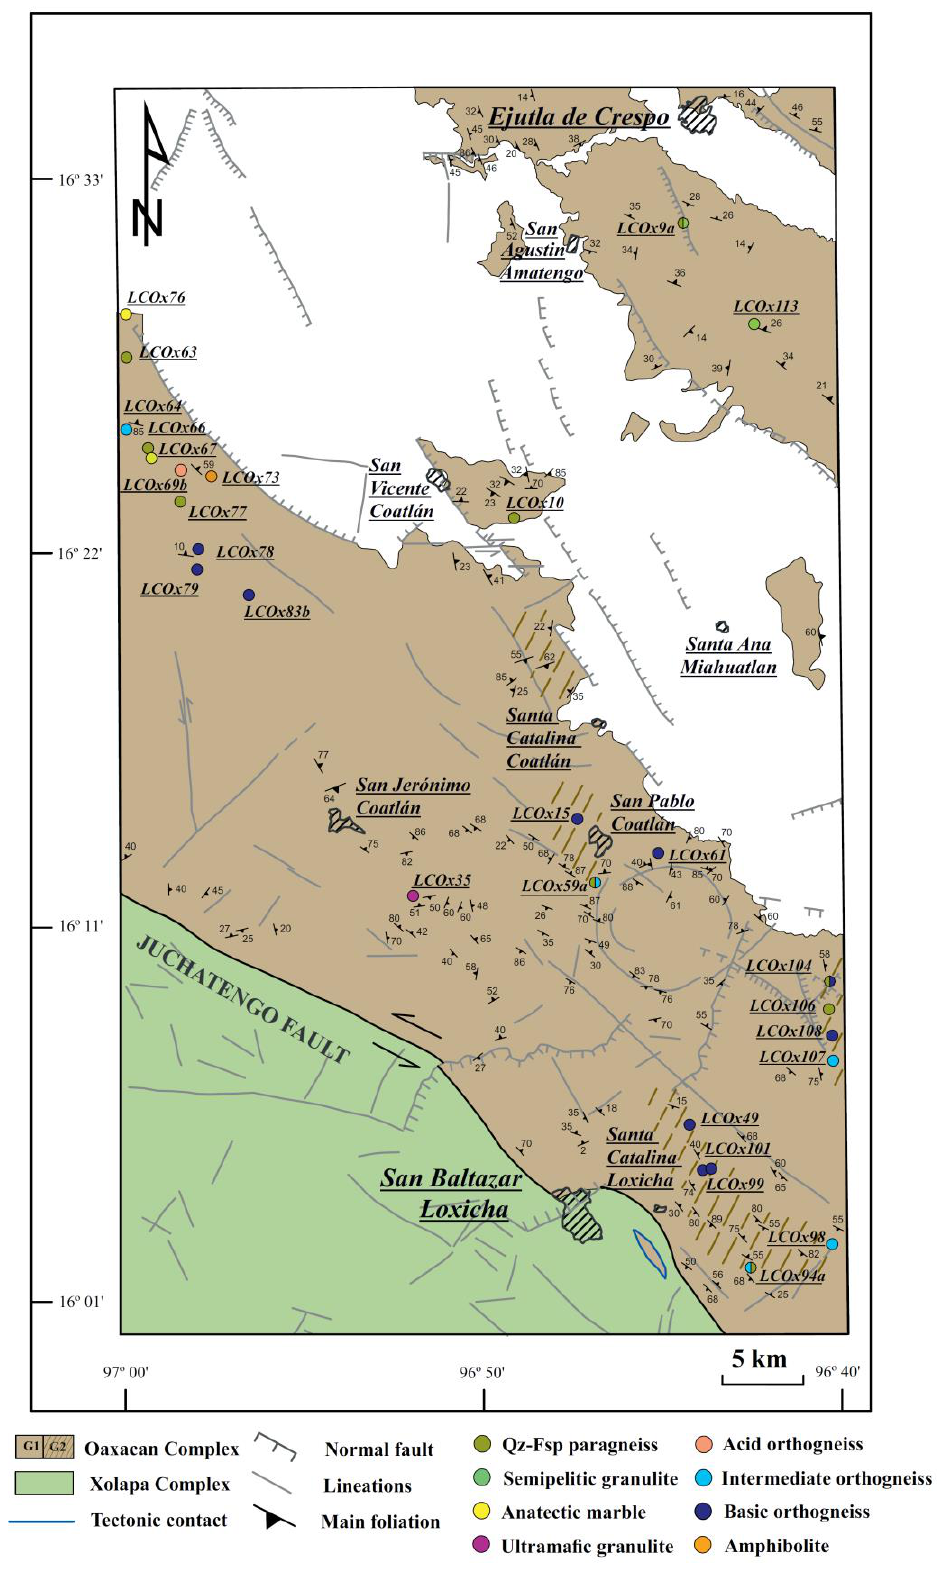
Figure 2. Simplified geological and structural map of the study area located between Ejutla de Crespo and San Baltazar Loxicha, with sample locations. Modified from 1:50,000 geological maps of Ejutla de Crespo [33] and San Baltazar Loxicha [34] and a 1:250,000 geological map of Zaachila [35]. The white colour corresponds to a Mesozoic and Cenozoic cover.